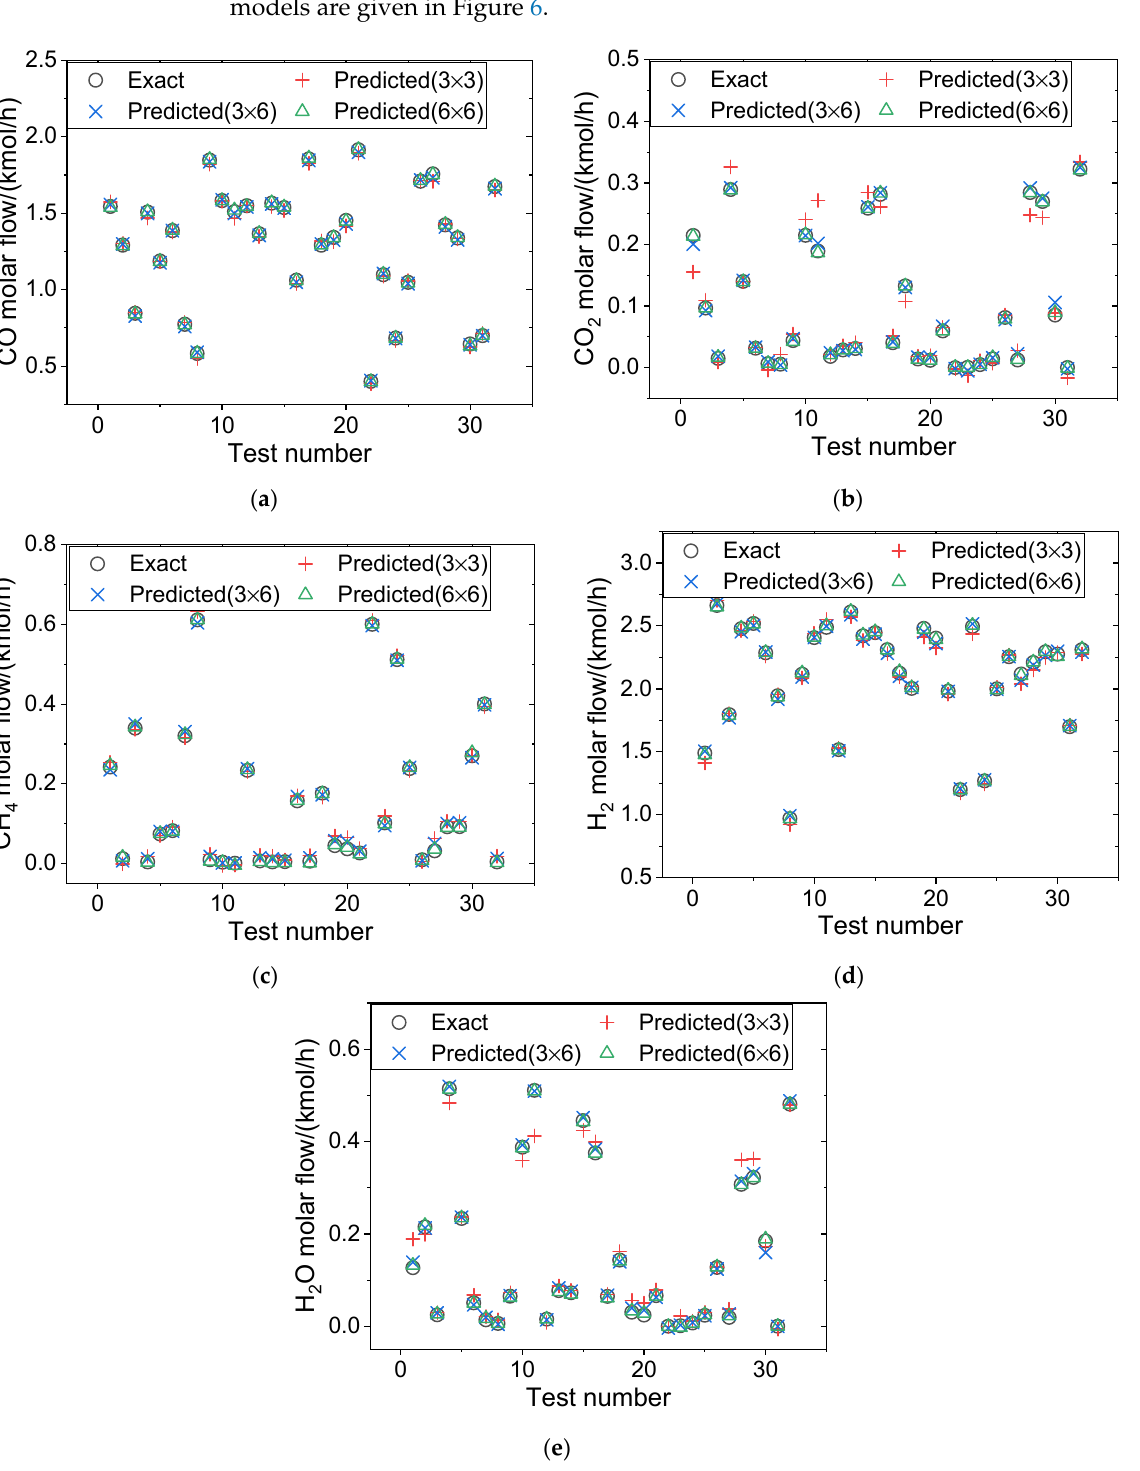
Figure 6. Prediction results of the BRM products using established ANN models: ( a ) CO; ( b ) CO 2 ; ( c ) CH 4 ; ( d ) H 2 ; ( e ) H 2 O.